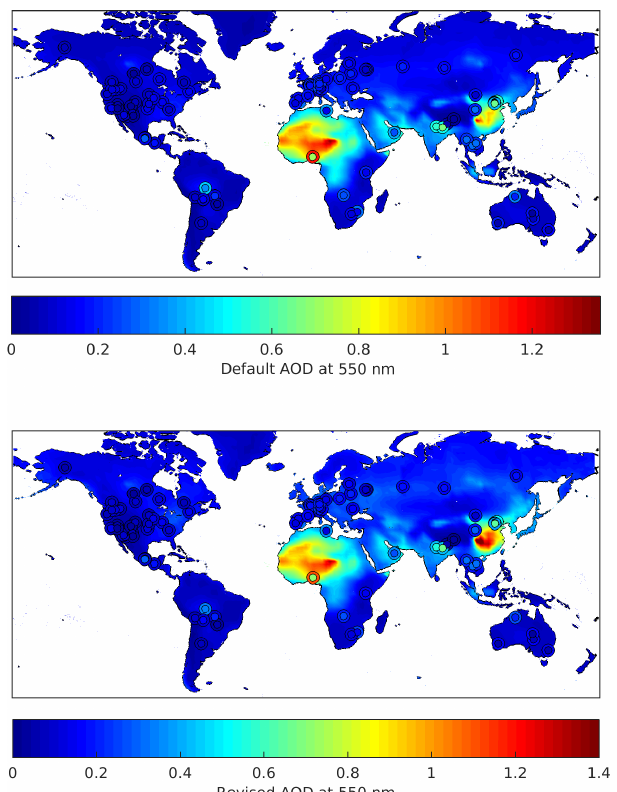
Figure B2. Global comparison for the year 2006 of AERONET AOD (inner circles) and GEOS-Chem coincident simulated AOD (outer rings) using default optical tables.